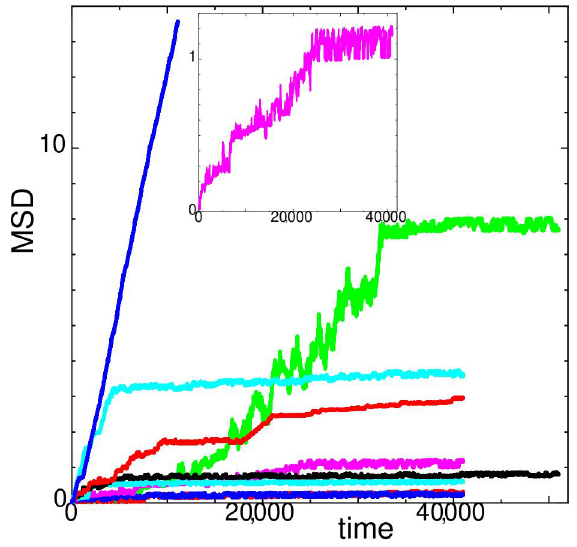
Figure 4. Mean square displacement of state J at temperatures T = 99 (red), 102 (green), 104 (blue), 106 (magenta), 112 (cyan), 114 (black), 116 (red), 118 (cyan), and 120 (blue) for system size N = 5376. Lower values of MSD at lower temperatures when plotted with the same color. Inset show close up of T =